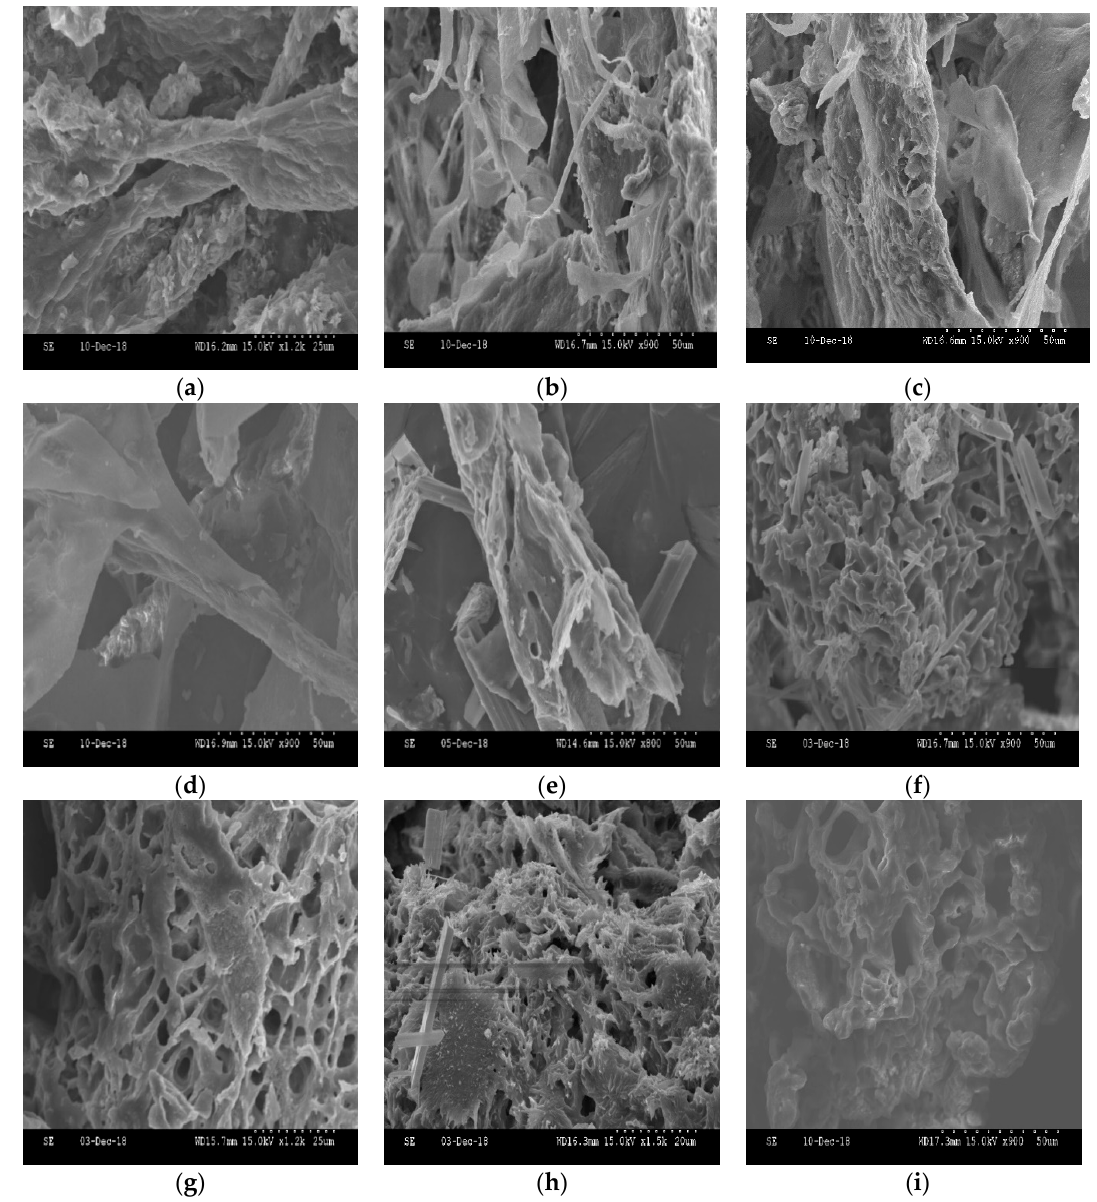
Figure 7. HC morphology changes during the hydrolysis alkaline treatment: ( a ) 0 min, ( b ) 10 min, ( c ) 15 min, ( d ) 20 min, ( e ) 30 min, ( f ) 1 h, ( g ) 2 h, ( h ) 3 h, ( i ) 4 h.